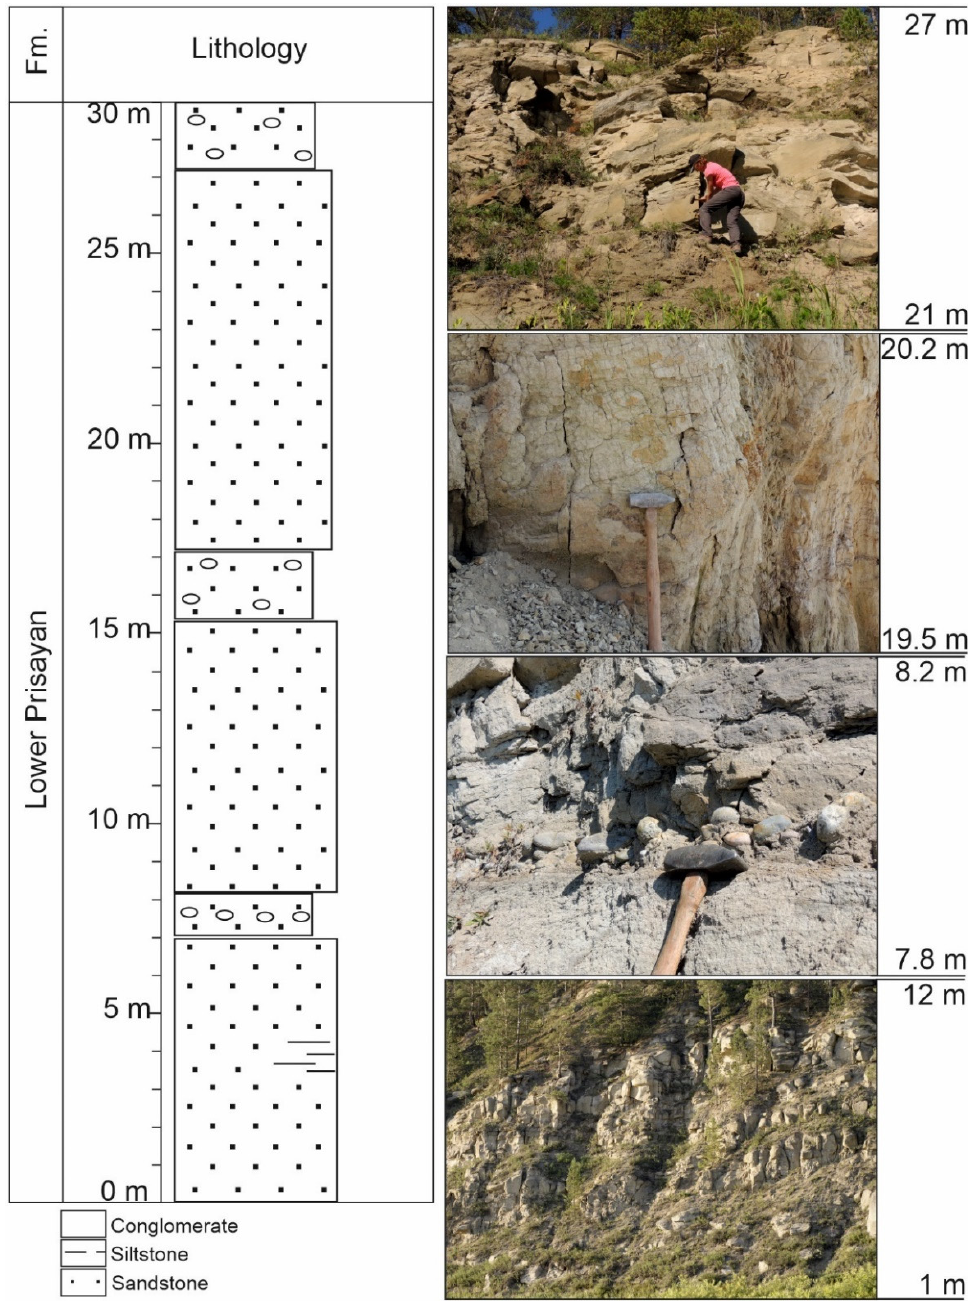
Figure 7. Section of the lower Prisayan Fm. sampling in the area of Ust-Baley village.